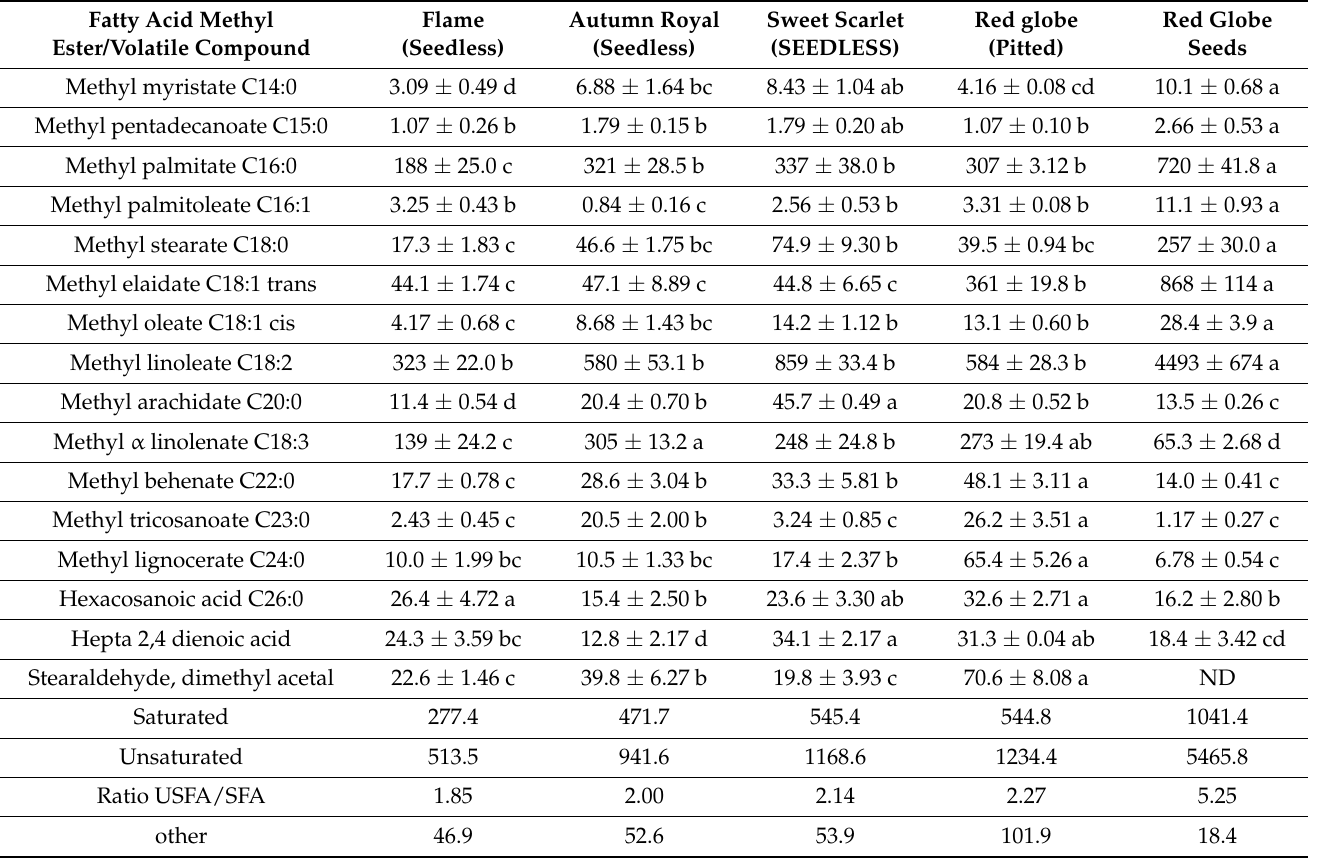
Table 2. Fatty acid methyl esters (FAME) content ( µ g/g fresh weight) in grape varieties (flame, autumn royal, sweet scarlet, red globe pitted, and red globe seeds) using